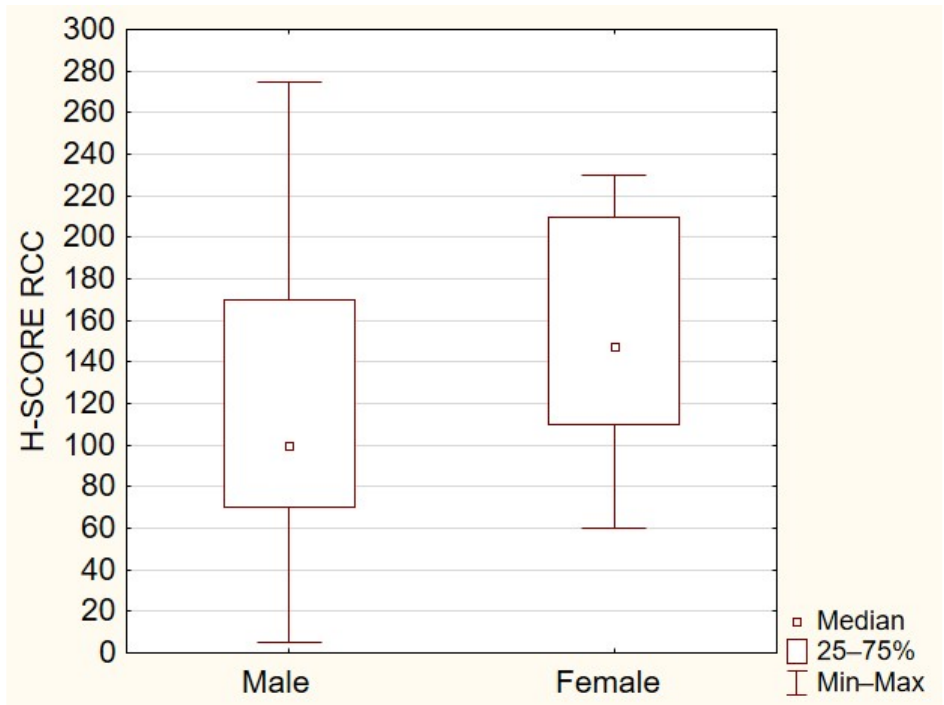
Figure 5. The difference in TOLLIP expression depends on sex ( p < 0.05).